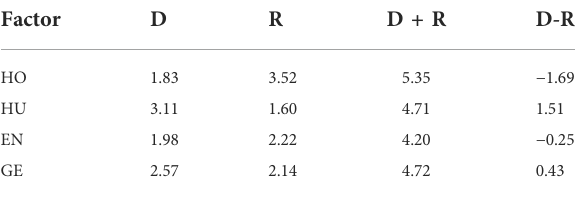
TABLE 5 The comprehensive impact value of green users ’ emotional